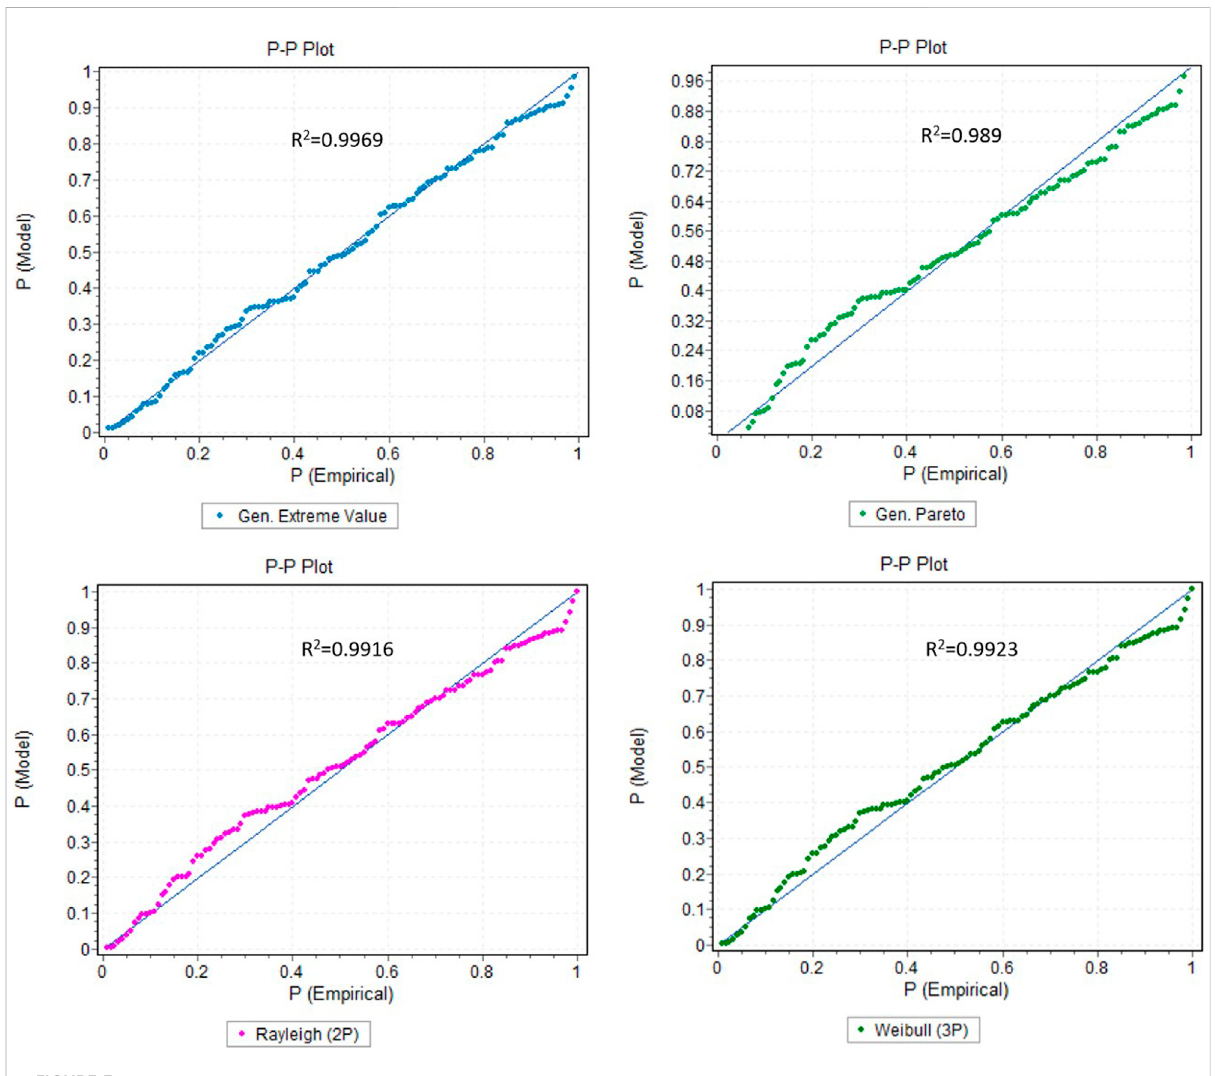
FIGURE 3 Probability-Probability Plot for various